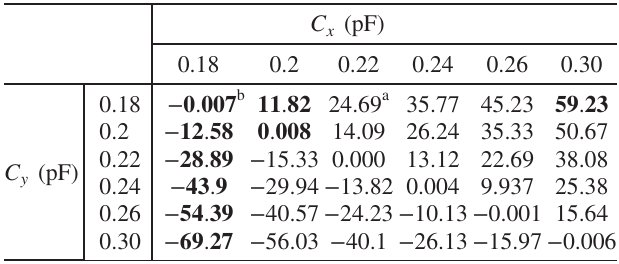
TABLE III. Simulated θ wave (at 10 GHz).